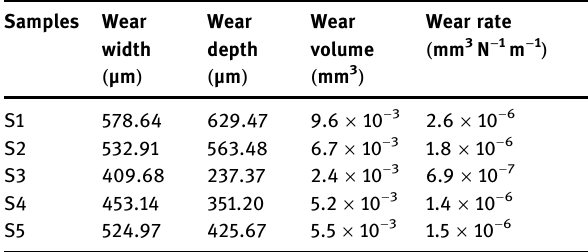
Table 5: Tribological properties of S1 – S5 samples Samples Wear